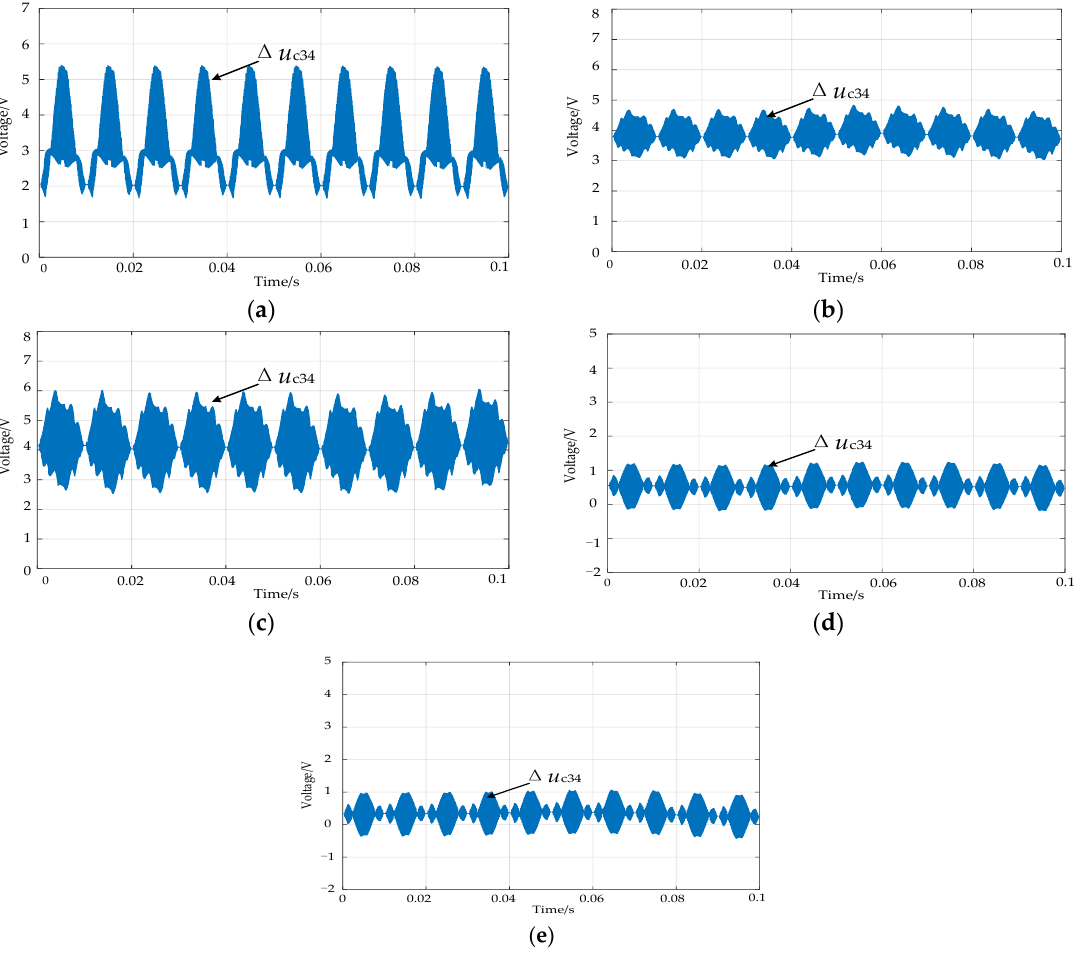
Figure 11. The voltage fluctuation of ∆ u c34 under different modulation methods during steady-state operation. ( a ) SPWM. ( b ) SVPWM - 1. ( c ) SVPWM - 2. ( d ) SVPWM - 3. ( e ) SVPWM - 4(hybrid).